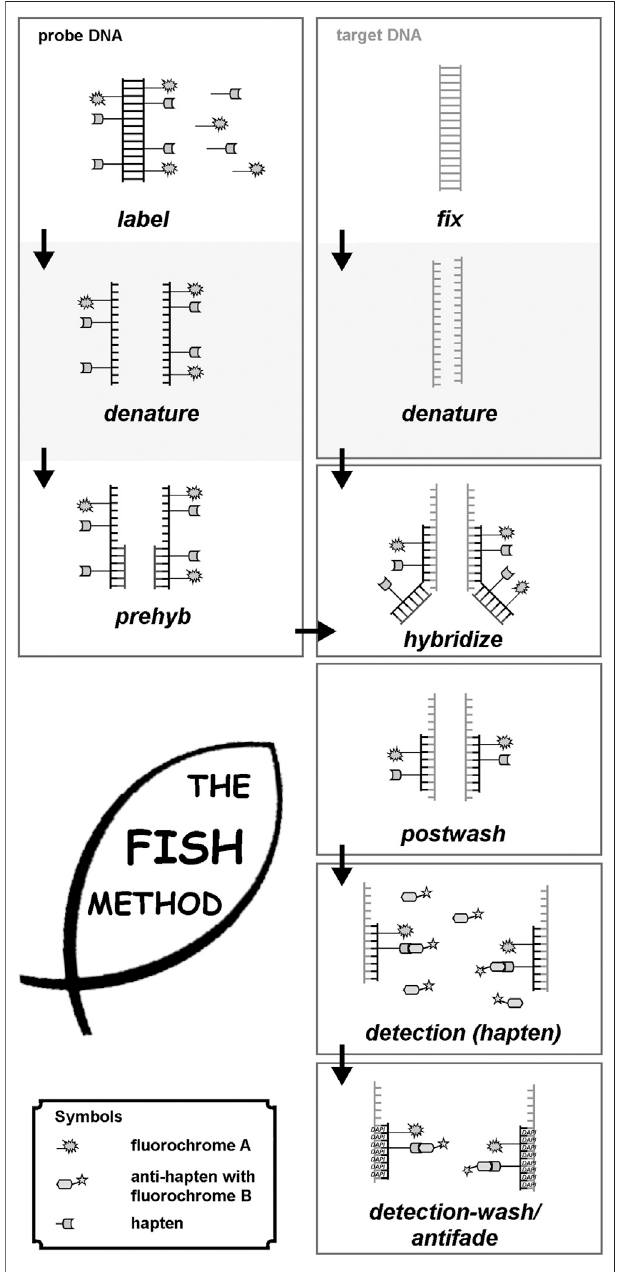
FIGURE 1 | Principle of FISH is given here schematically. First probe- and target DNA are denatured. Probe-DNA is either labeled (commercial probes),orneedstobelabeled,e.g.,byPCR-approaches.Probe-DNAispre- hybridized with unlabeled repetitive DNA and then hybridized to the target DNA, being fi xed on a glass-slide. After hybridization, postwashing is done to get rid of super fl uous probe and blocking DNA. In case a non- fl uorescent hapten was used to label the probe-DNA, this has to be detected by an anti-hapten with a fl uorochrome. Finally, after washing of the detection- solution, slides can be sealed with antifade and DNA-staining dye (like DAPI (cid:1) Dipehnylaminoindol), and evaluated under a suited microscope.